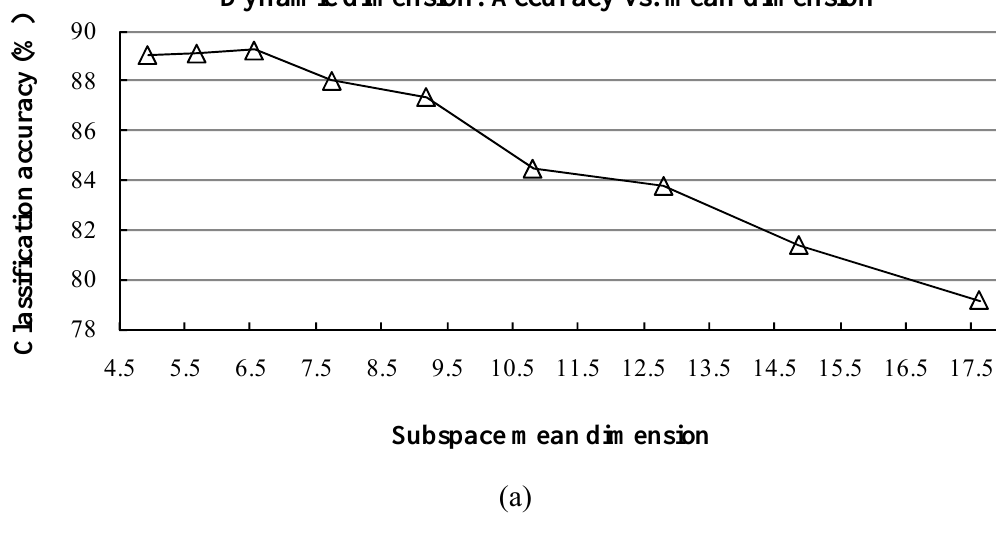
Dynamic dimension. Iteration vs. mean